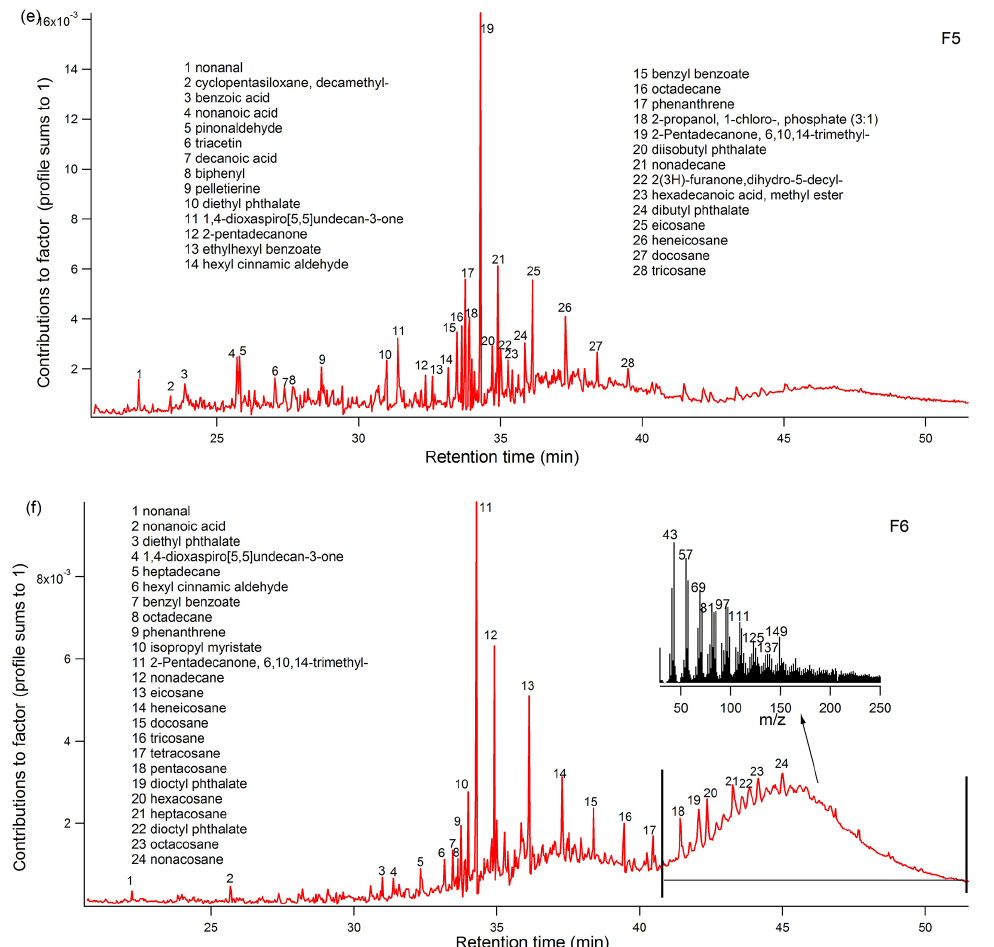
Figure 5. The chromatogram profiles of the TAG–Bin six-factor solution. A bin width of five scan points and retention time shift correction are used here. The mass spectra in panels (d) (factor four) and (f) (factor six) are the summed mass spectra of what are largely UCM components in the indicated retention time